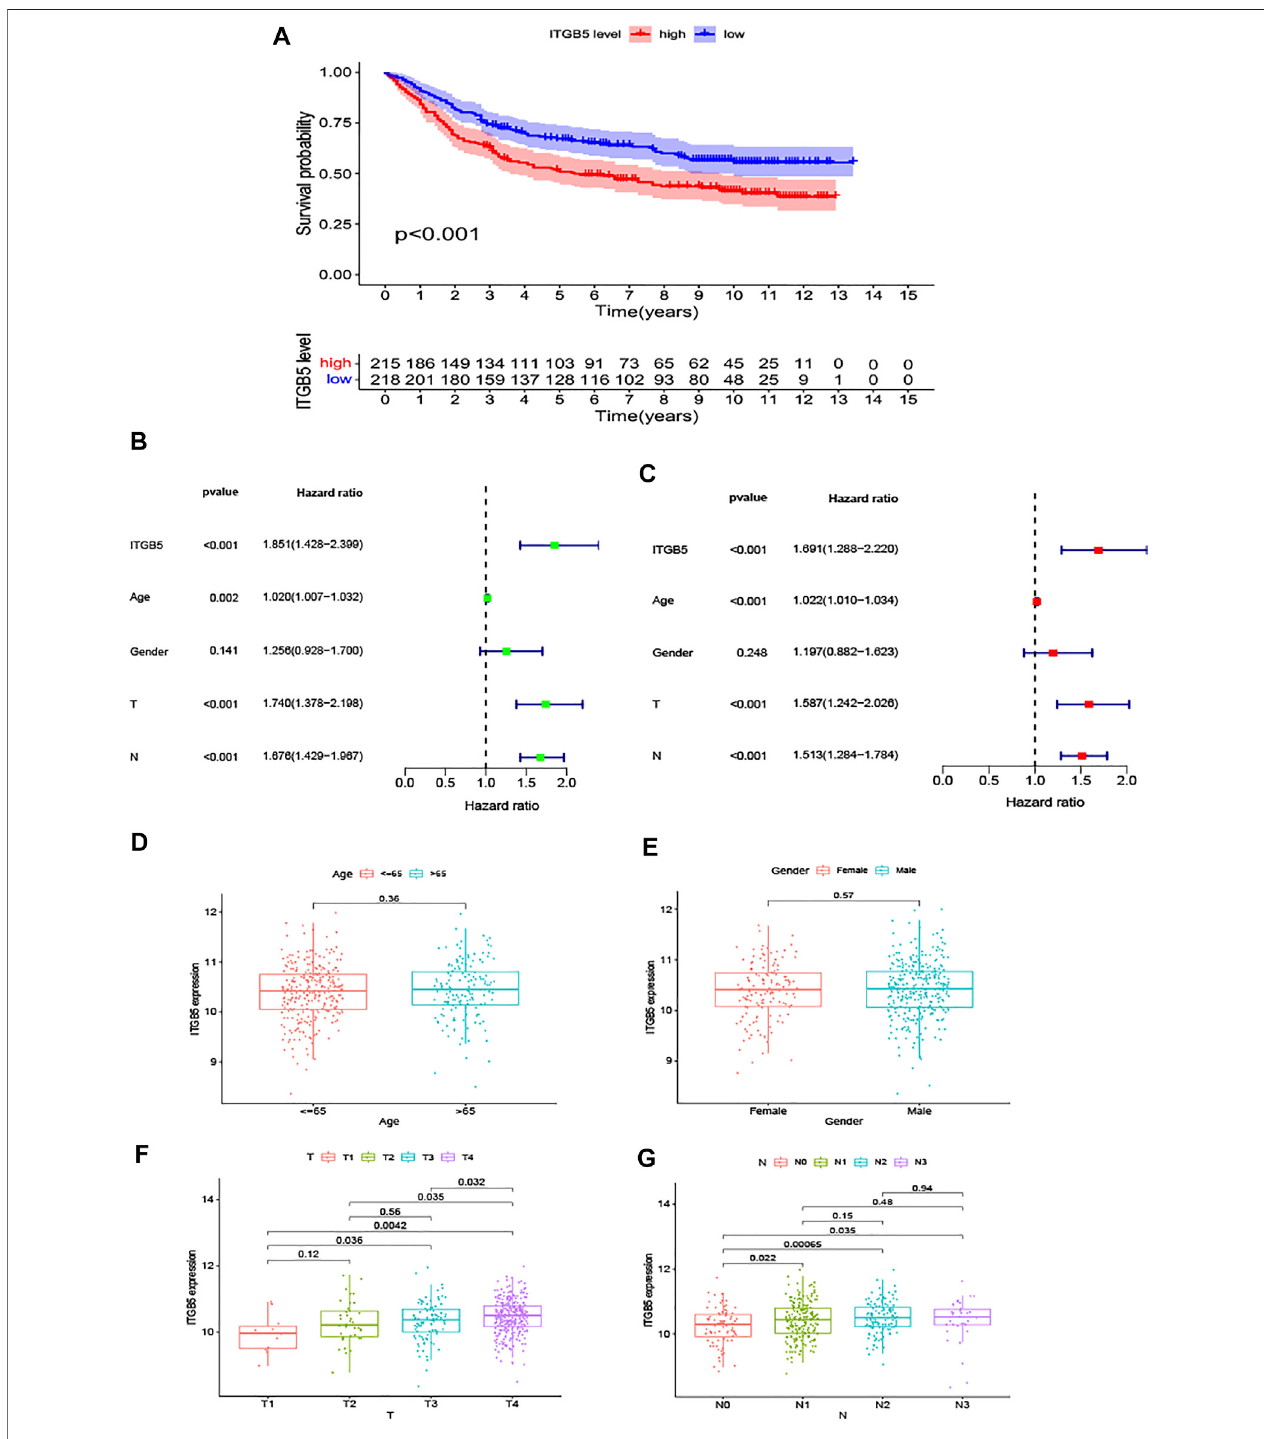
FIGURE7| TheresultsintheGEOtestcohort. (A) TheK-Mcurvesforthetwogroups(highvs.lowexpression). (B,C) Theforestmapsofunivariateandmultivariate Cox regression analysis in the GEO data set. (D,G) The expression of ITGB5 assigned by clinical factors, comprising age, gender, T stage, and N stage.